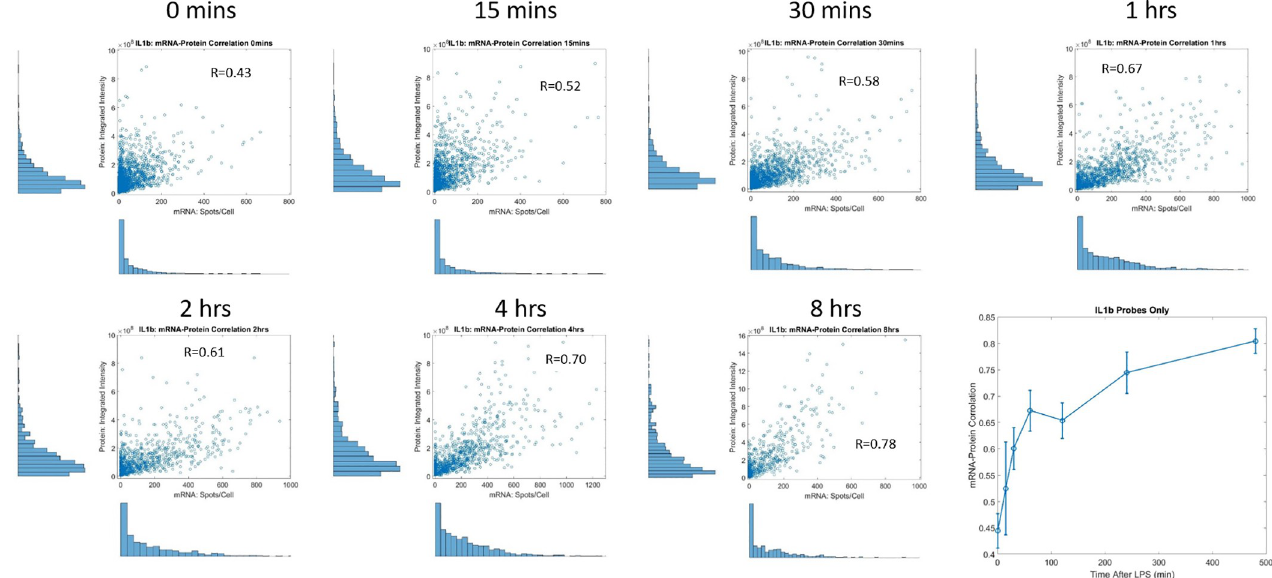
Fig 8. Scatter plot of mRNA-Protein correlation for IL1 β and plot of correlation coefficient over time. Without LPS, there is a weak correlation between mRNA and protein content for IL1 β . After LPS stimulation we see an increase in correlation between the two.